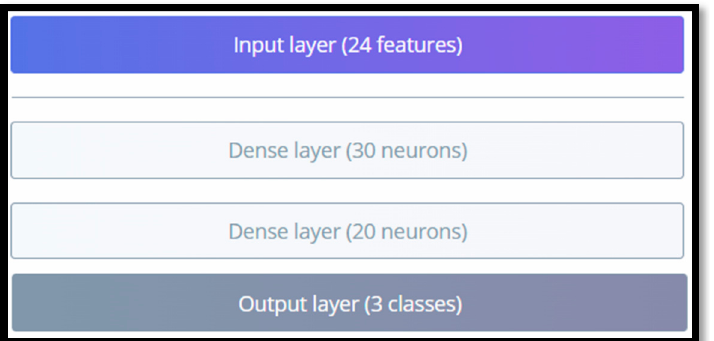
Figure 4. The fully connected neural network architecture includes an input layer (1 × 24), two hidden layers (30, 20 neurons) with ReLU activation functions, and an output layer (1 × 3) with a Softmax activation function .